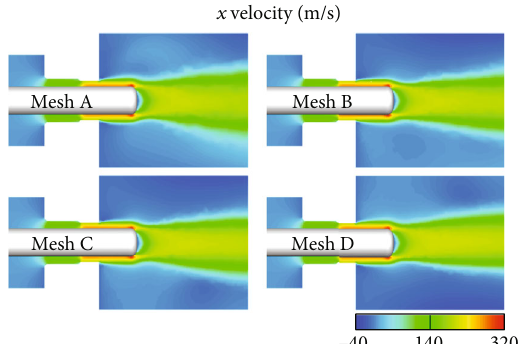
Figure 8: Close-up plots of x -velocity distribution in the vicinity of the pintle tip for di ff erent mesh